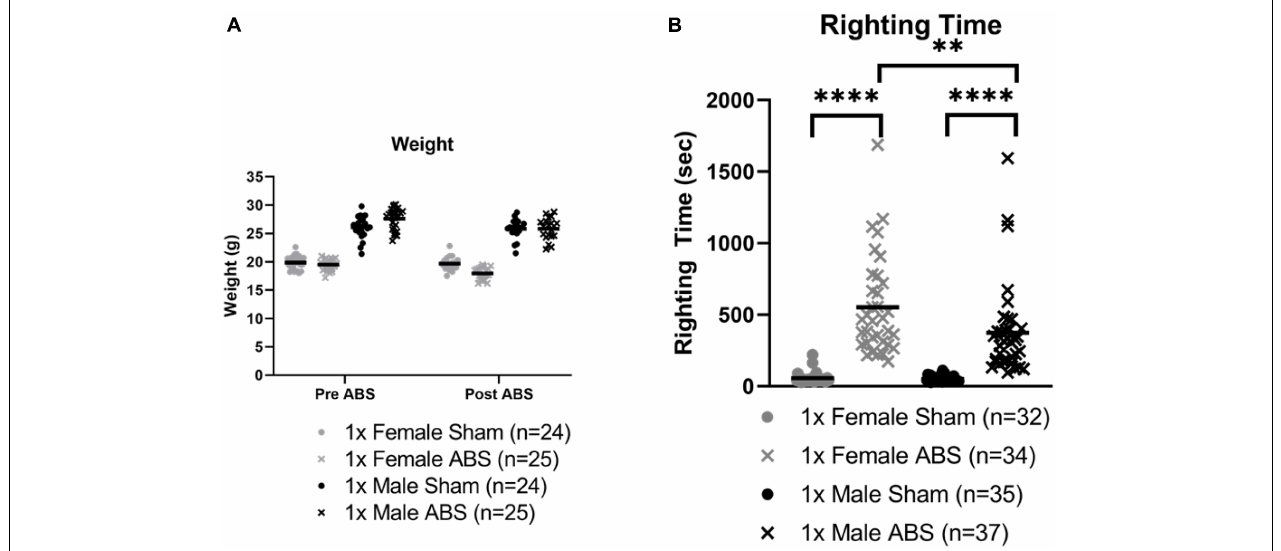
FIGURE 3 | Weight and righting time changes after bTBI. (A) Animal weight before and one day after ABS exposure for the behavior cohort of mice. Due to differences in baseline body weights, the percentage change in body weight for each mouse was computed for pre- and post-injury sham or ABS treatment (data not shown; see text). ANOVA indicated there was a significant greater difference in females compared to males overall and a significantly greater percentage of body weight loss in ABS animals, but no sex differences due to injury. (B) Righting times of all cohorts, behavior and Evans blue, immediately after a single blast. The Mann Whitney U test ( U = 3, p < 0.0001) demonstrated that the duration of the righting reflex was longer for shock wave exposed females compared to female sham mice. Male injured mice also demonstrated a longer righting reflex compared to sham counterparts ( U = 1.5, p < 0.0001). A comparison of righting reflex duration in injured mice indicated the responses after shock wave exposure in males and females were significantly different ( U = 370.5, p = 0.0026) with longer righting times for female mice. Bars indicate means. ∗ p ≤ 0.05, ∗∗ p ≤ 0.01, ∗∗∗∗ p ≤ 0.0001. No significant correlations were found between righting reflex and loss of body weight ( τ = 0.000, p = 1.000) or percentage loss of body weight ( τ = 0.032, p = 0.846) for females, or righting reflex and loss of body weight ( τ = –0.167, p = 0.312) or percentage loss of body weight ( τ = –0.105, p = 0.516) for